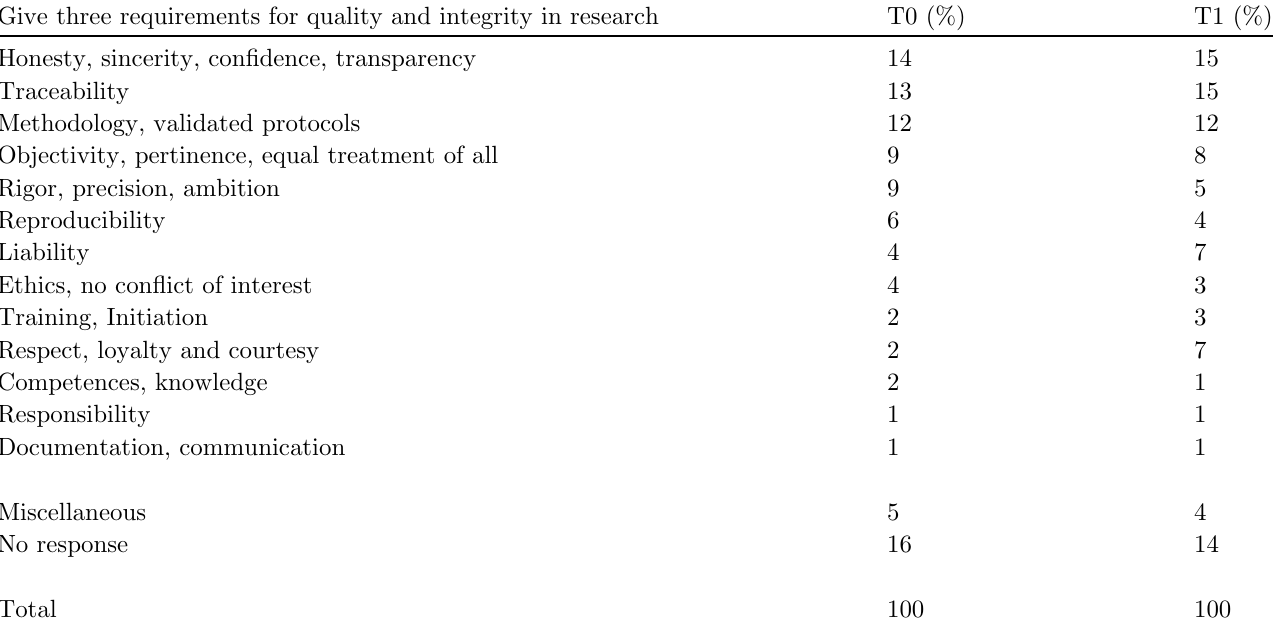
Table 1. Items that are considered part of research integrity and